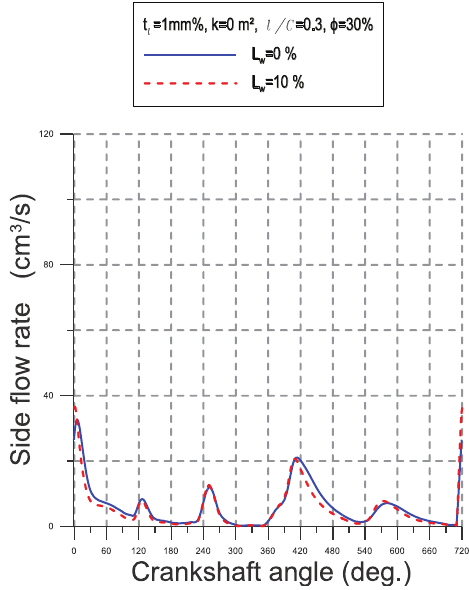
Fig. 13. Effects of dynamic misalignment on side leakage fl ow over an entire cycle.